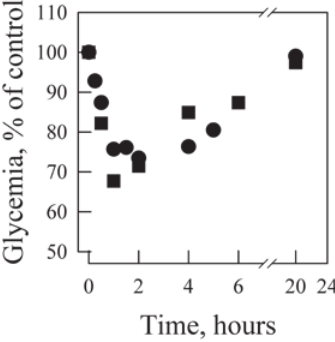
Figure 2 - Time-dependence on the hypoglycemia response to subcutaneous mouse amylin. Mice were treated with either amylin (1 μg in either saline or PBS solution) or a control solution of either saline or PBS administered via subcutaneous injection in 4 h-fasted mice (n≥3 per group). Glycemia was monitored using blood collected from the tail tip while the mice were fasting, conscious and unrestrained. The results from the treatment group were subtracted from the control group, and the results are expressed here as percentage change. Experiments were performed by different analysts at 25 °C (■) or 19 °C (●), by using either 0.9 % saline (■) or PBS (●) as the amylin diluting solution, using different glucometers, amylin batch and animals from distinct vivarium. Further details can be found in the Methods section .